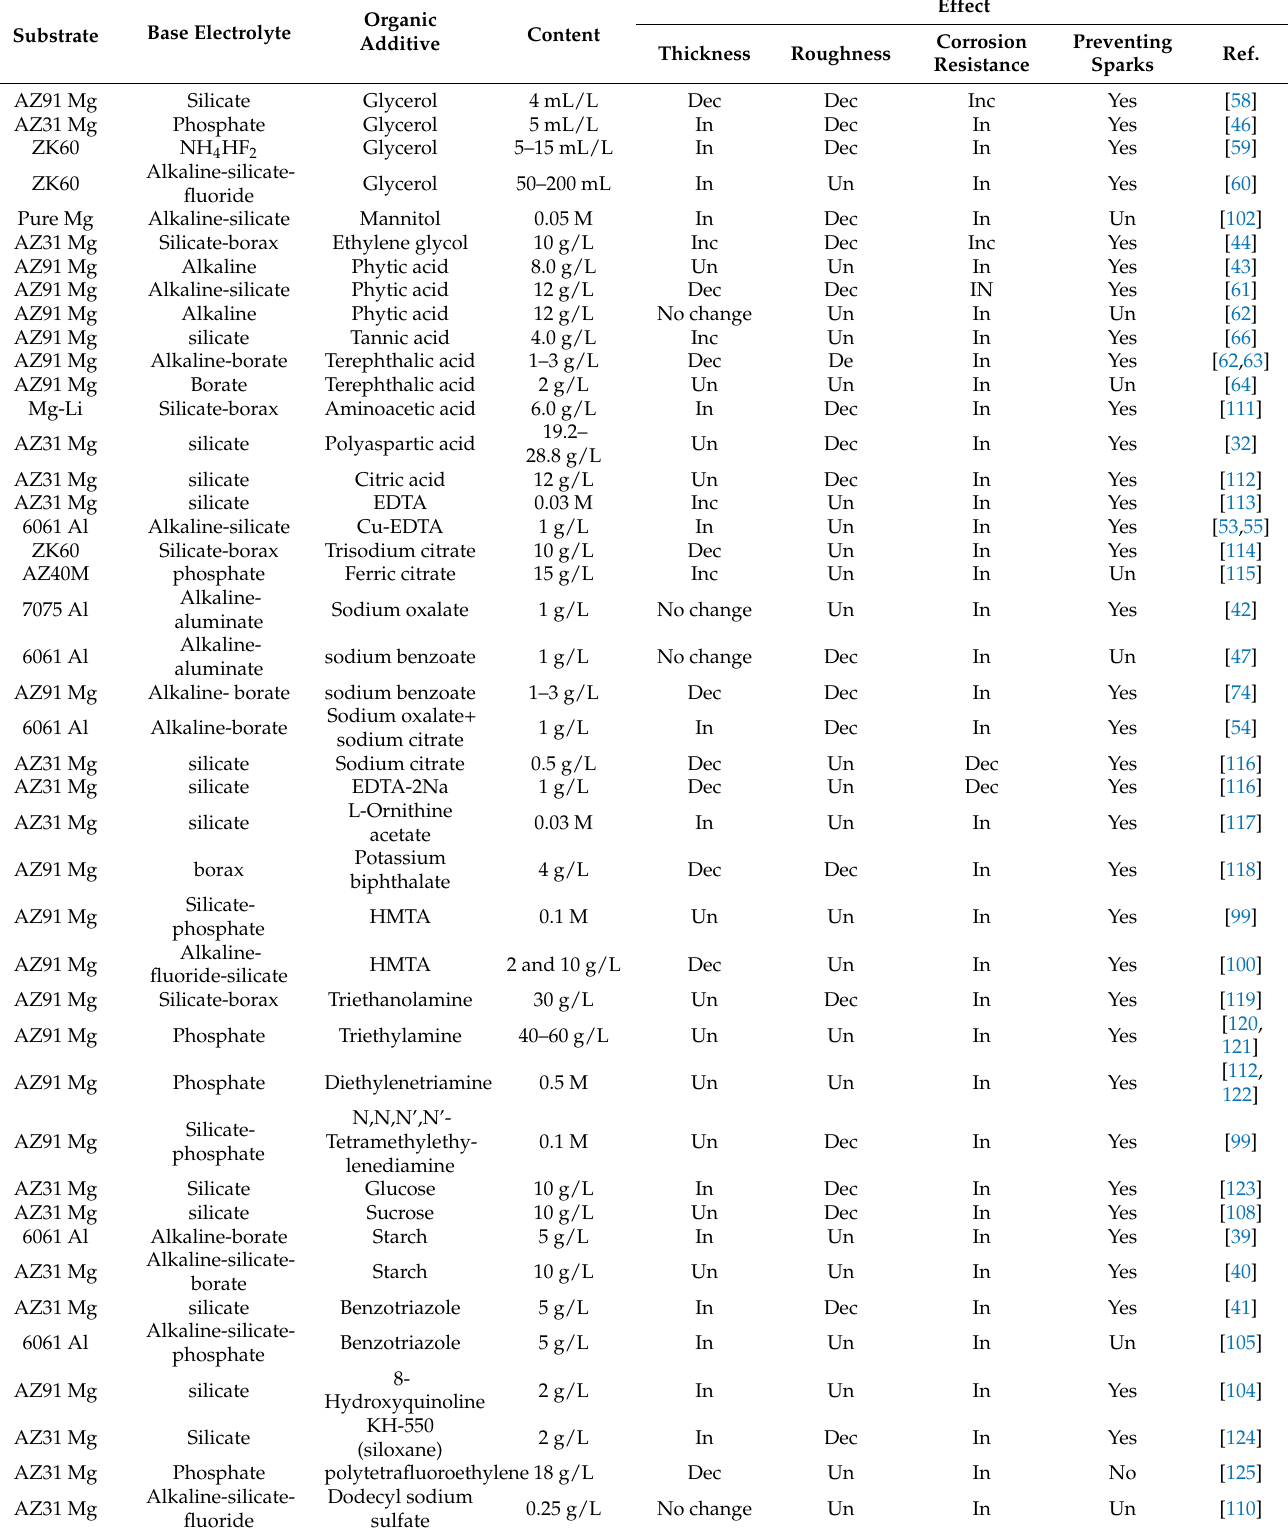
the coating thickness, and improved the protective properties of the PEO coatings made on the metallic substrates and their alloys. Table 1. Effects of organic additive on the performance of PEO coatings deposited on Mg and its alloys. The influence of organic additives on the properties of PEO coatings made on Al alloys are also presented.